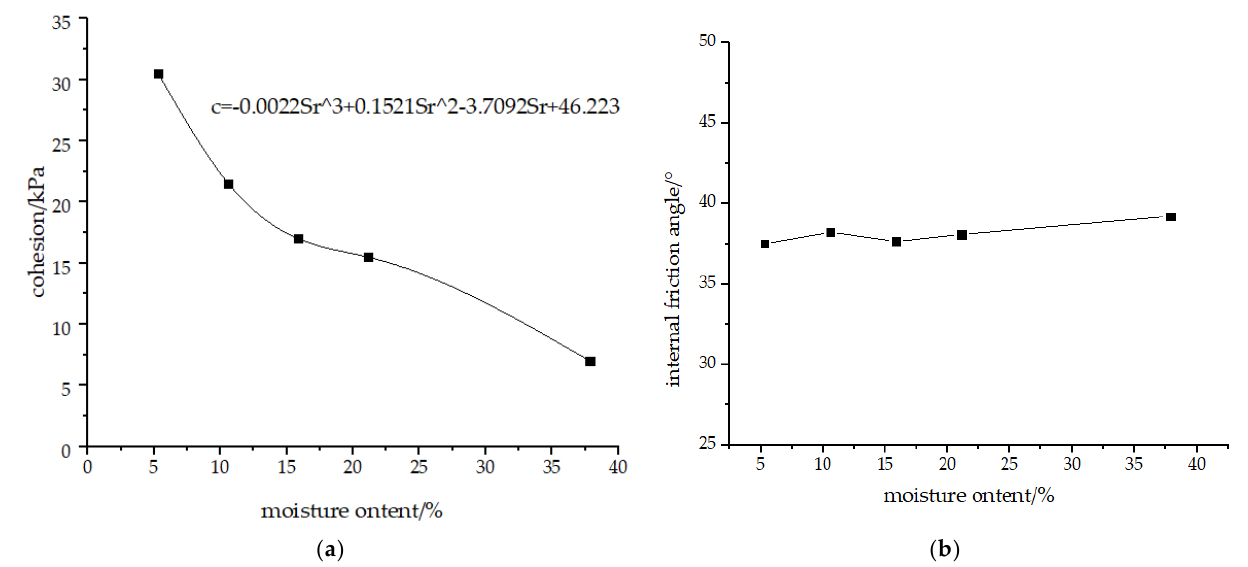
Figure 8. The Relationship Between Shear Strength Parameters and Moisture Content. ( a ) Cohesion of Yellow River silt under different moisture contents; and ( b ) Internal friction angle of Yellow River silt under different moisture contents.